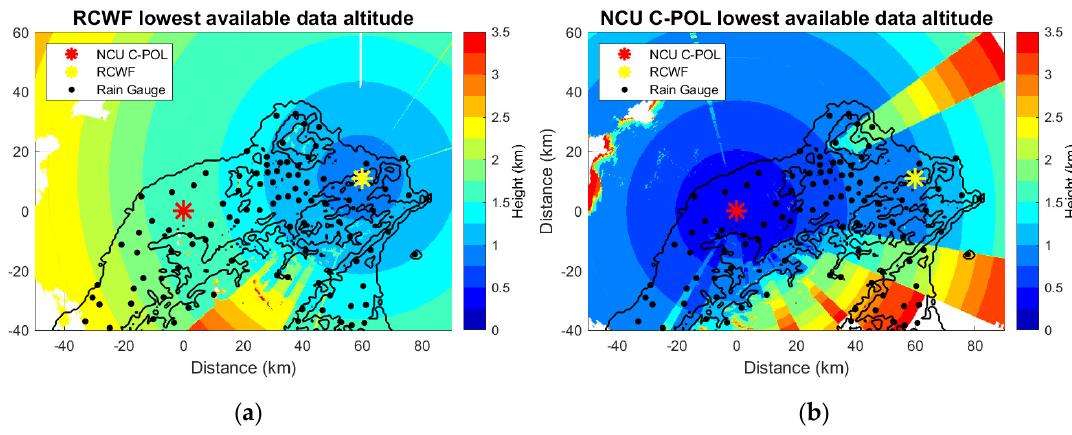
Figure 1. An example of ( a ) RCWF and ( b ) NCU C-POL lowest available data altitude (km) for quantitative precipitation estimation (QPE) after the partial beam blockage (PBB) and non-meteorological signal removal.